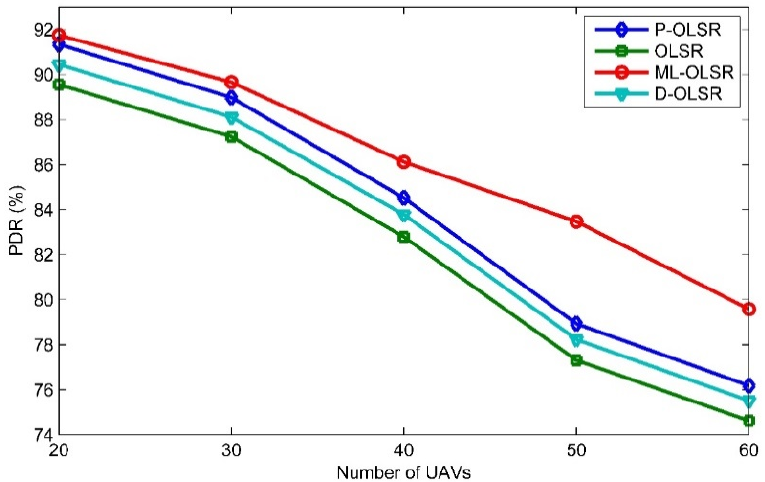
Figure 10. PDR vs. number of UAVs.